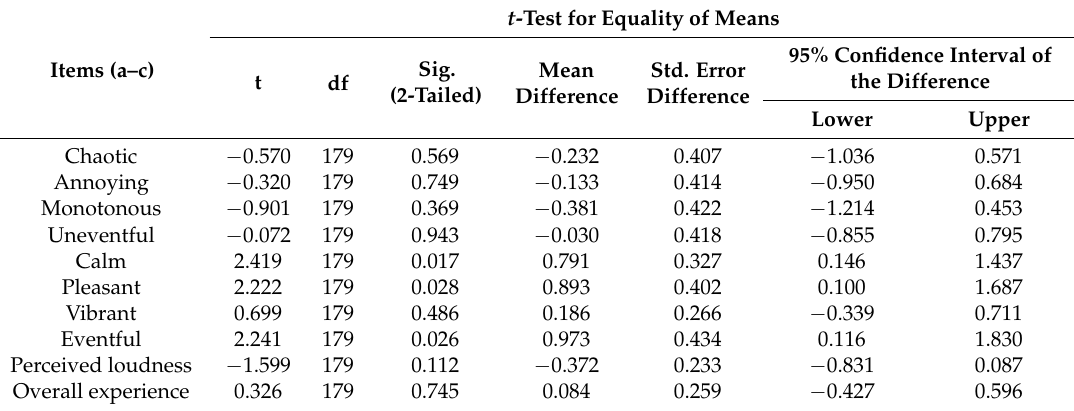
Table 4. Independent-samples t -tests for the Soundscape appraisal, Perceived loudness and Overall experience items between the VDT